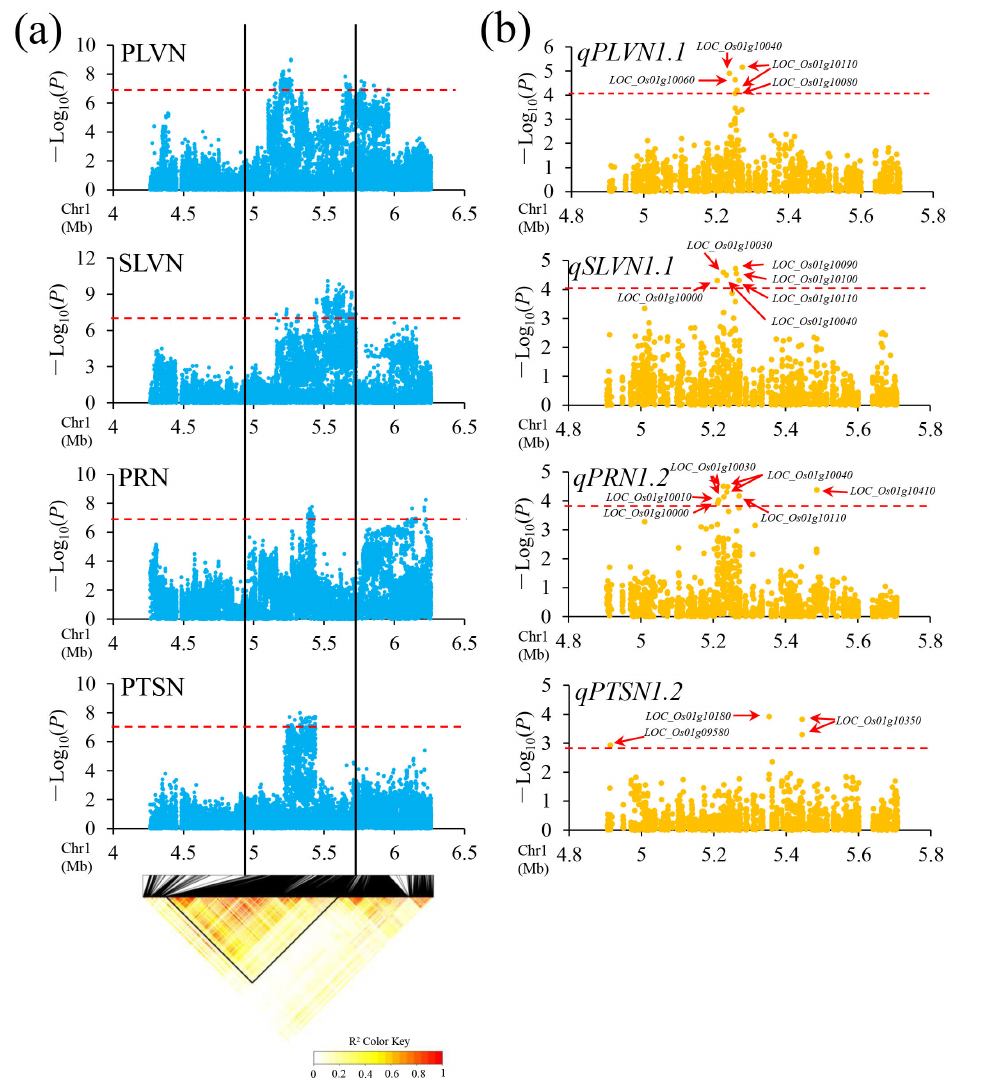
Figure 5. LD block and gene-based association analysis of the QTL cluster associated with qPLVN1.1 , qSLVN1.2 , qPRN1.2, and qPTSN1.2 on chromosome 1. ( a ) Local Manhattan plot (top) and LD block (bottom) surrounding the peak SNP on chromosome 1. Black lines indicate the candidate region for the peak SNP. ( b ) Gene-based association analysis of targeted genes within the LD block. Dash lines show the threshold to determine significant